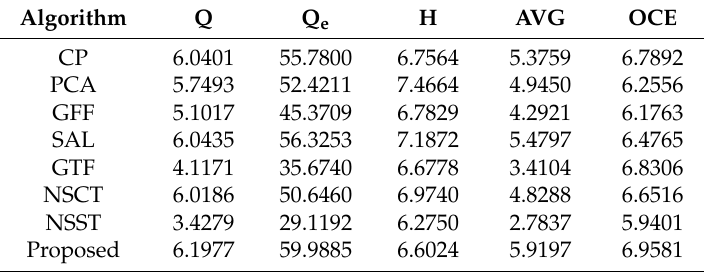
Table 1. Comparison of evaluation results of first experiment.